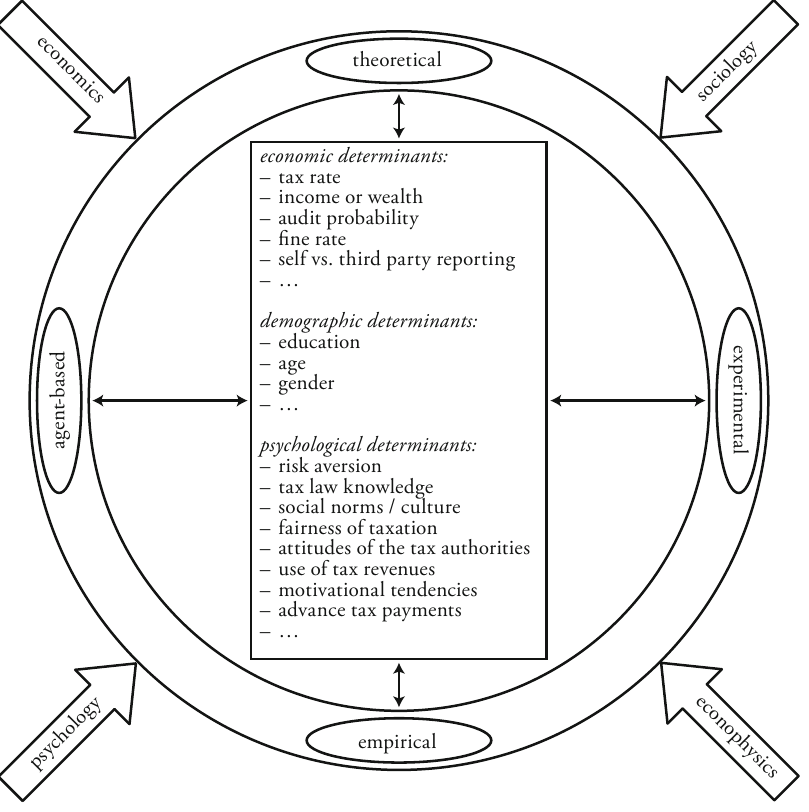
Figure 1: Academic Disciplines, Research Approaches and Possible Determinants of Tax Non-Compliance